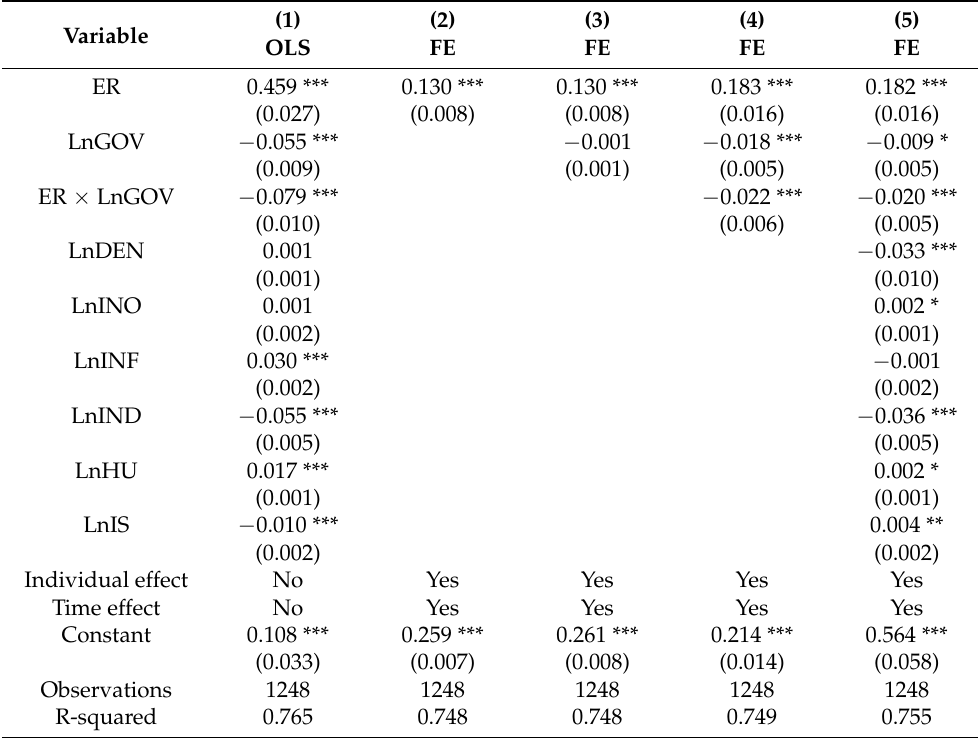
Table 3. Benchmark regression results.